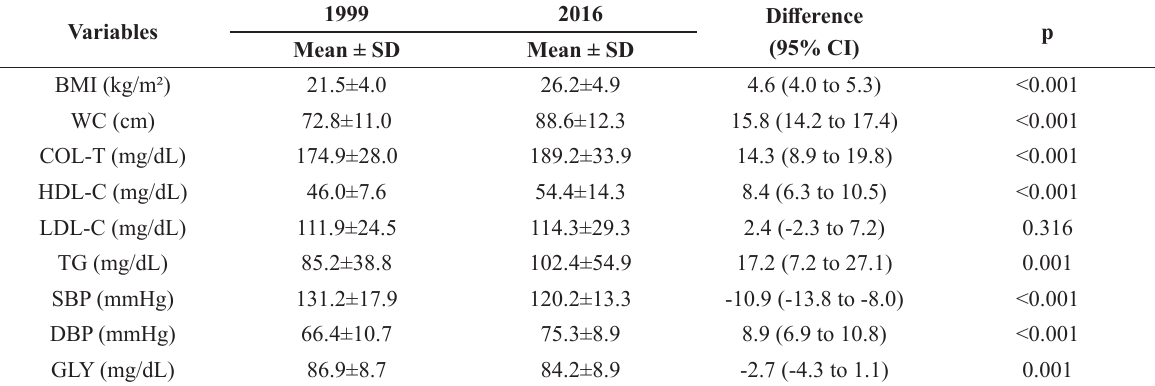
Variation in the cohort’s anthropometric and biochemical data during the follow-up period (1999-2016).